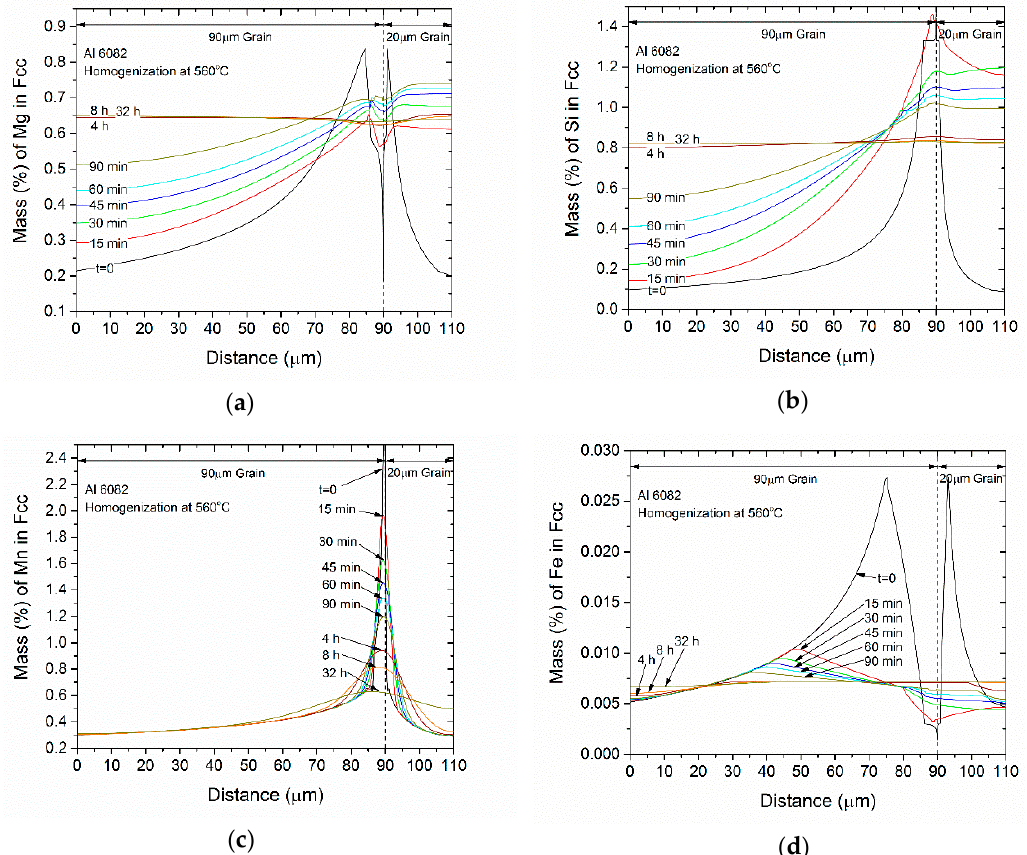
Figure 9. Evolution of concentration profiles during homogenization at 560 °C of 6082 alloy, ( a ) Mg, ( b ) Si, ( c ) Mn, and ( d ) Fe.